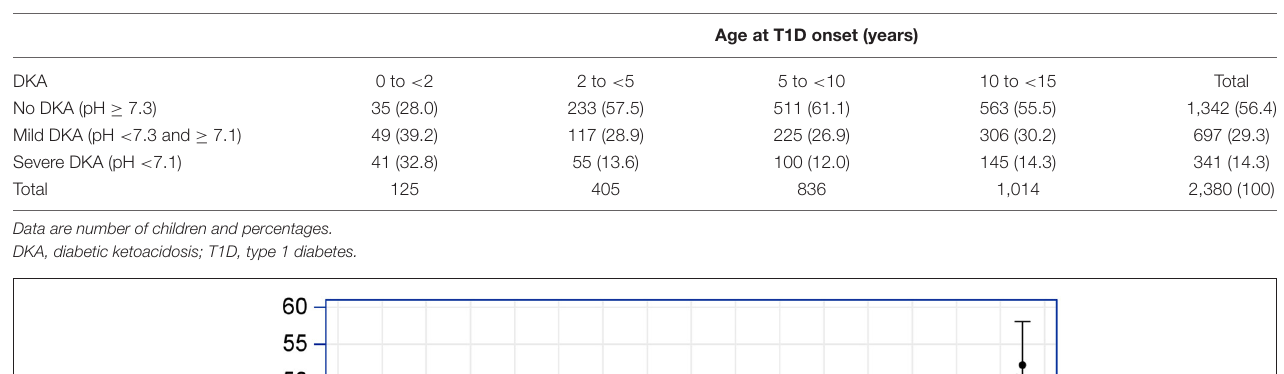
Age at T1D onset (years)